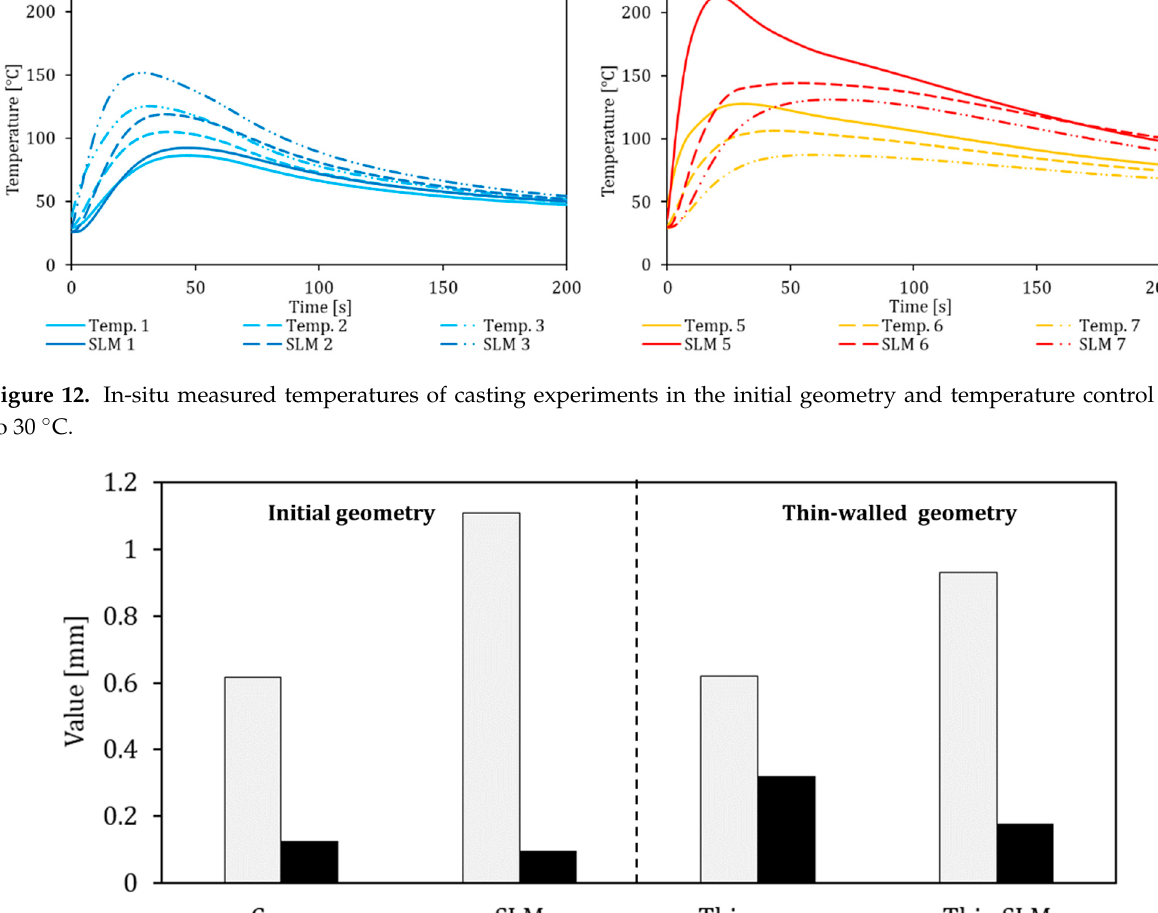
Figure 13. Mean distortion and standard deviation for the different series.